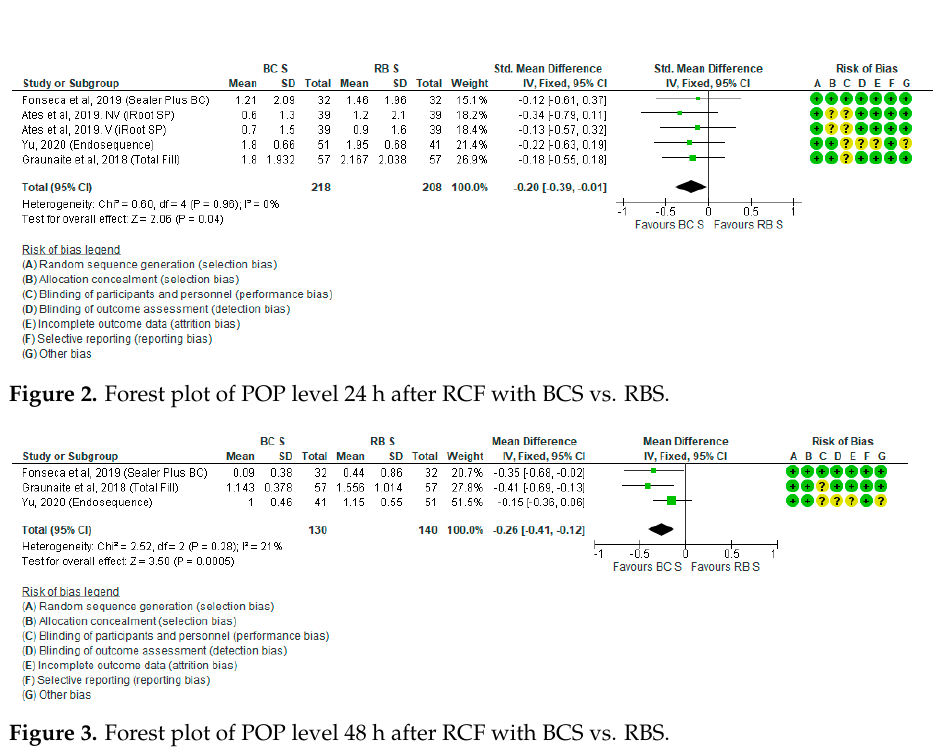
Figure 3. Forest plot of POP level 48 h after RCF with BCS vs. RBS.